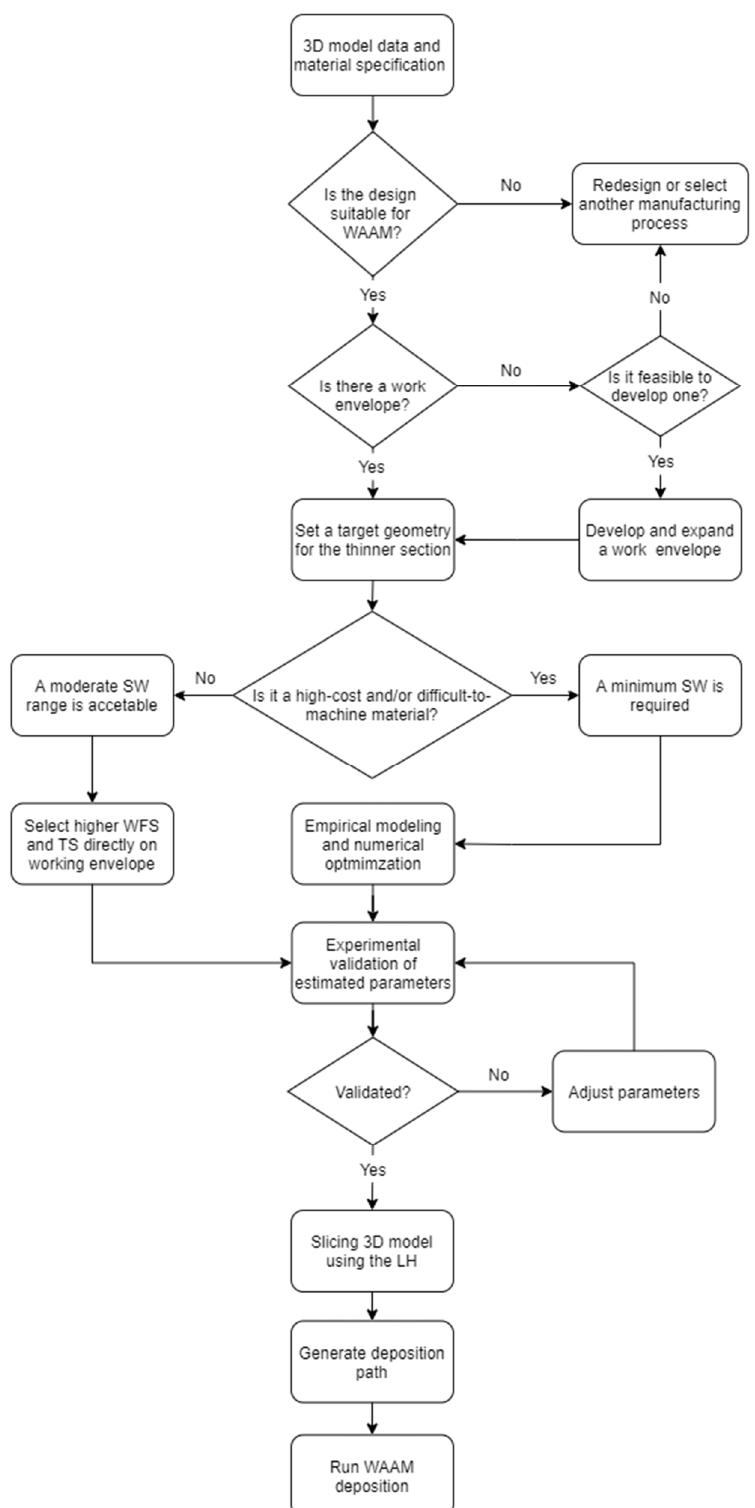
Figure 20. Flowchart of decision-making procedure towards preform quality in WAAM.